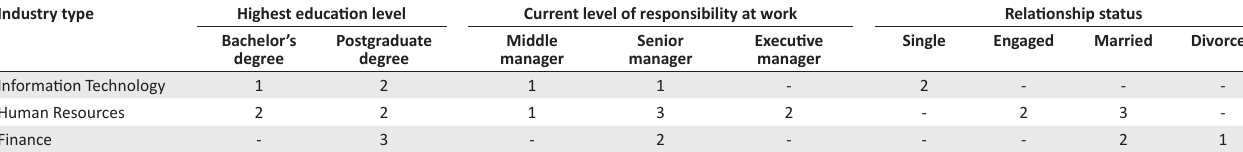
TABLE 1: The characteristics of the